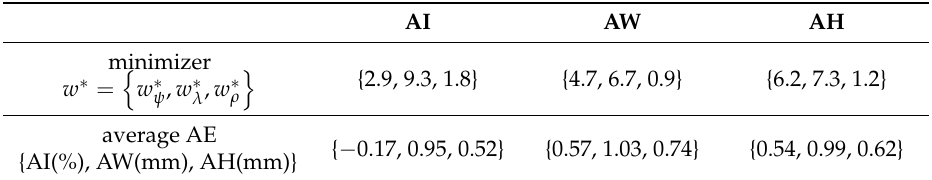
Table 5. Assessment optimal minimizer and error of foot-arch parameter estimation of the 77